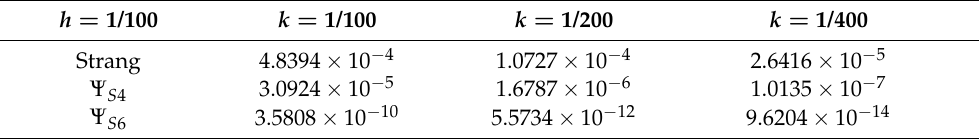
Table 1. Time error for three symmetric-splitting methods with h = 1/100 for final time T = 1. h = 1/100 k = 1/100